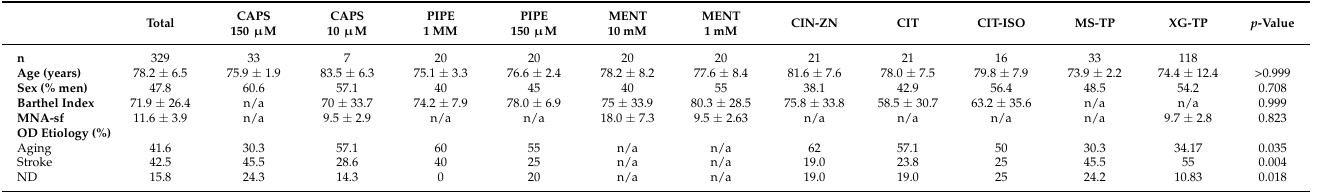
Table 1. Demographic characteristics of study groups. Data are presented as mean ± SD unless specifically